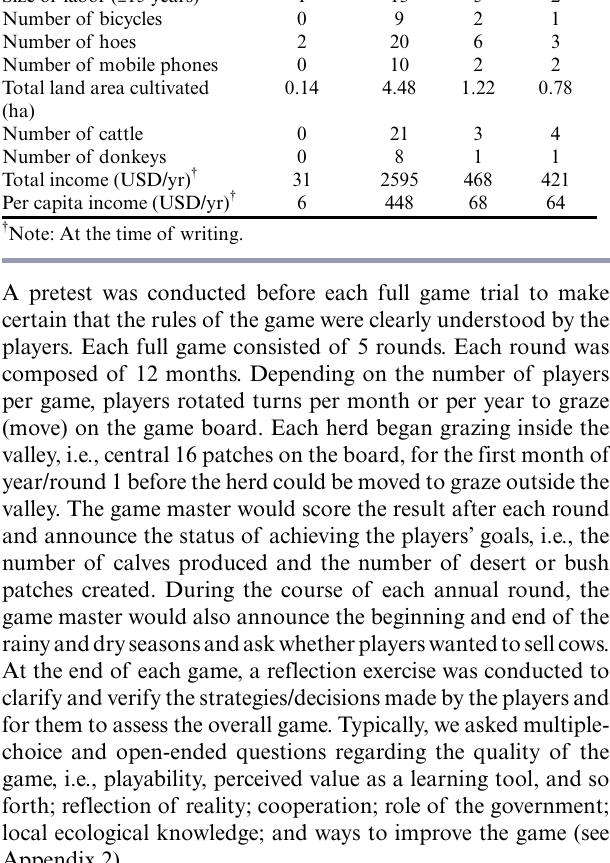
Fig. 5 . Yields by mean annual rainfall category among grazing game trials in Ghana (N = 23).